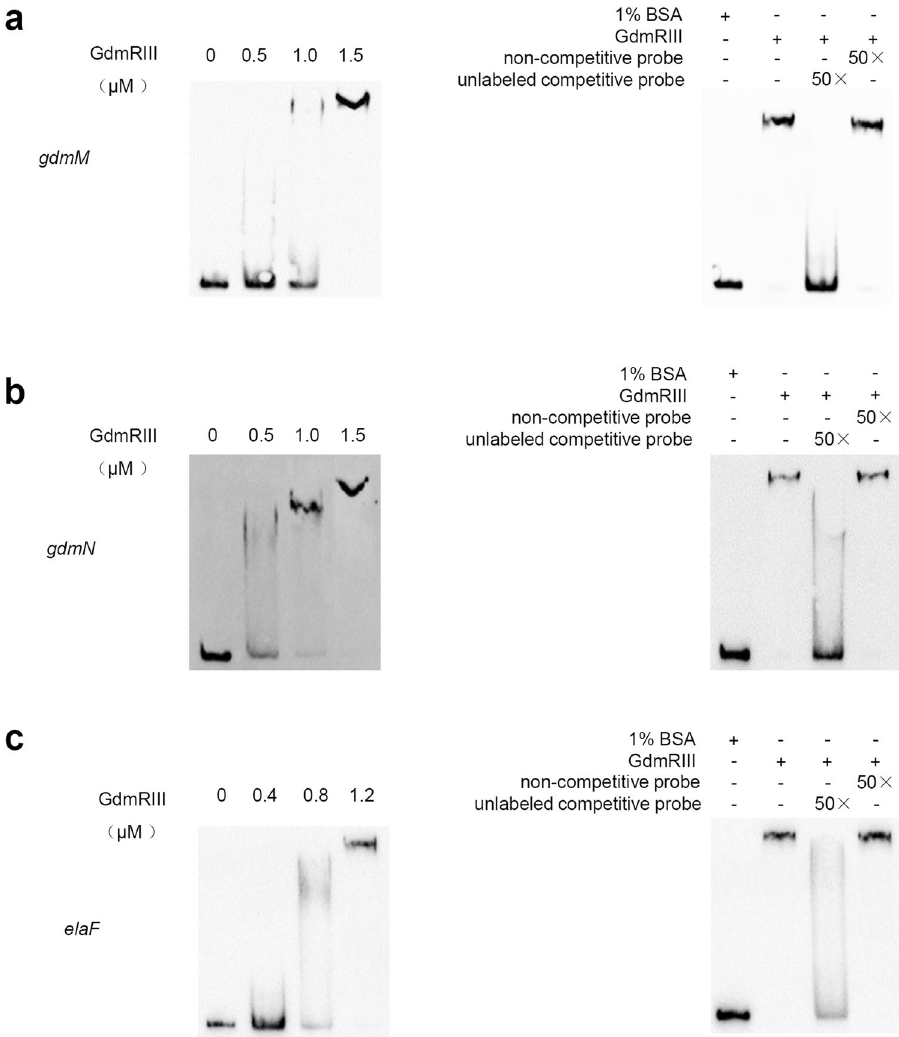
Figure 5. EMSA analyses of the binding of GdmRIII to its targets in the geldanamycin and elaiophylin gene clusters. The binding of GdmRIII, with gradually increased protein concentrations, to the promoter regions of gdmM ( a ), gdmN ( b ), and elaF ( c ) are shown. For controls, 1% BSA was used instead. The concentrations of GdmRIII used in the competitive EMSAs were 1.5 μ M for gdmM , gdmN and 1.2 μ M for elaF . The concentration of promoter sequences used in the normal or the competitive EMSAs was 0.3 nM. The experiments were repeated three times, and the representative images are